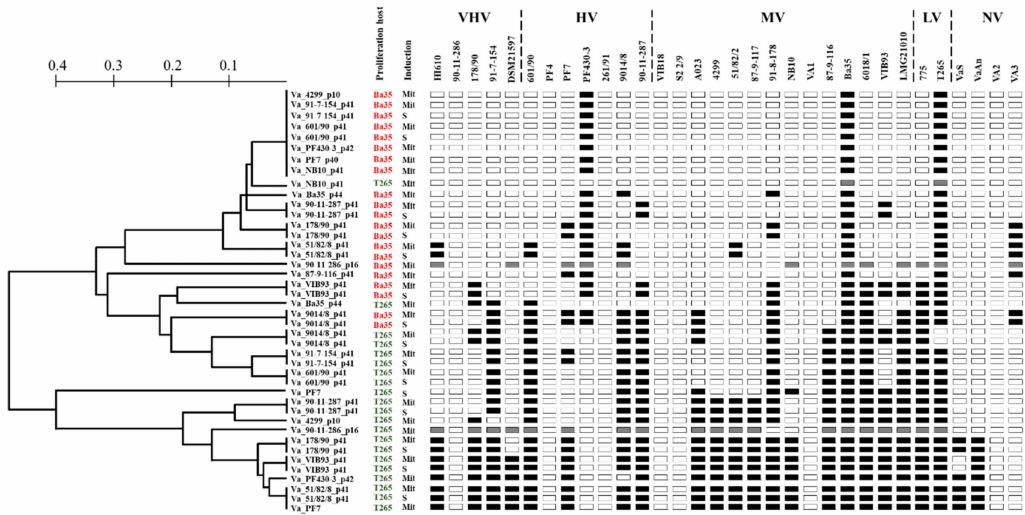
Figure 2. Host range profiles of V. anguillarum phages. Phages were grouped based on their infectivity against 32 V. anguillarum strains using the unweighted-pair group method. Infectivity is categorized as: white “no inhibition observed”, gray “turbid inhibition zone”, black “clear inhibition zone”. Proliferation host (red or green colors) and induction method (Mit [mitomycin C], S [spontaneous]) were added to facilitate comparison. The virulence ranking of the strains is based on three fish larva models [12]: very high virulence (VHV), high virulence (HV), medium virulence (MV), low virulence (LV) and non-virulence